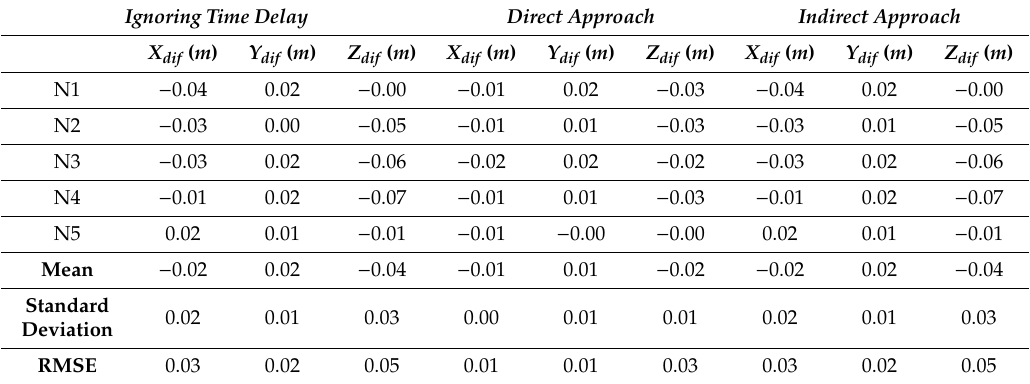
Table 15. Components and mean / standard deviation / RMSE of the di ff erences between check point and surveyed coordinates for the five check points for the DJI M600 platform—Sony RGB.